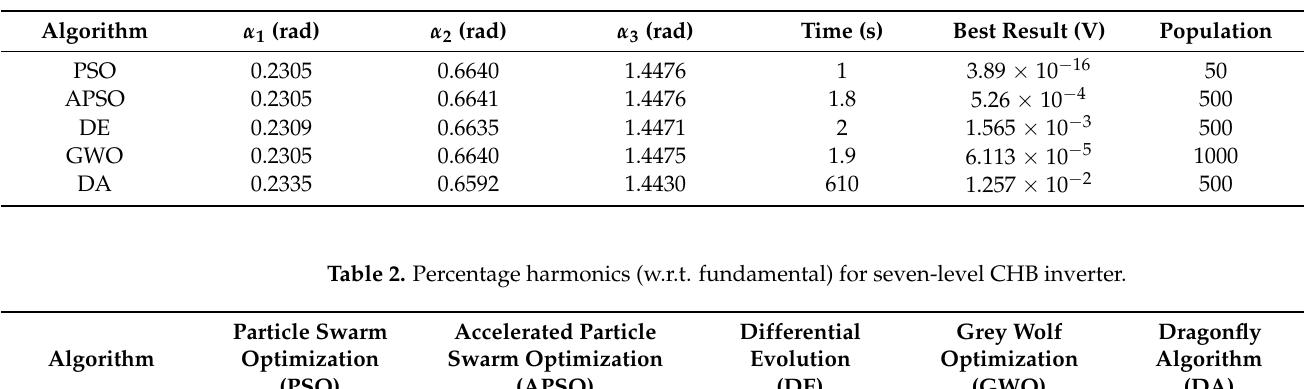
Table 1. Optimized switching angles for seven-level cascaded H-Bridge (CHB) inverter.